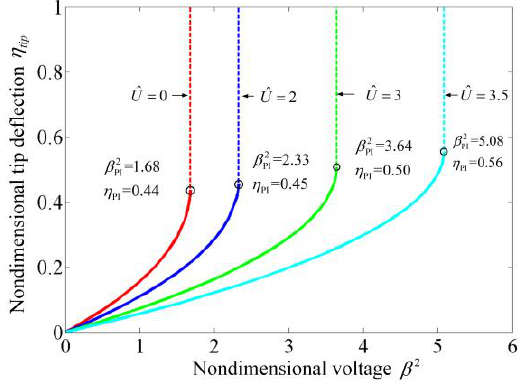
Figure 3. Static deflection of the suspended microchannel resonator for β 2 = 1 and various ˆ U .